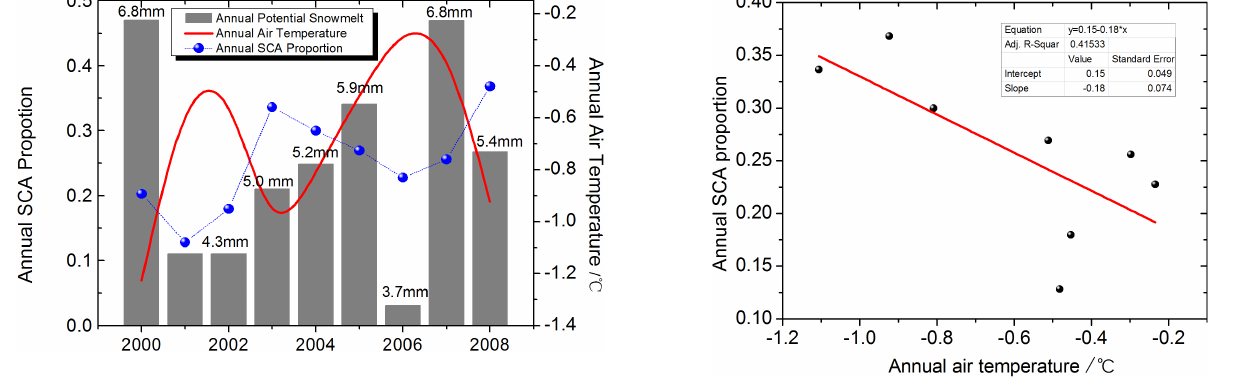
Fig. 14. Linear fit between annual SCA proportion and air temper- ature. The dataset duration is from 2001 to